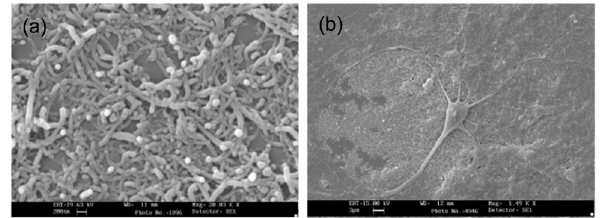
Figure 15: Neonatal hippocampal neuron adhesion ( b ) and survival were boosted by puri fi ed multiwalled carbon nanotubes ( MWNTs ) deposited on substrate ( a ) ( reproduced from ref. [ 110 ])